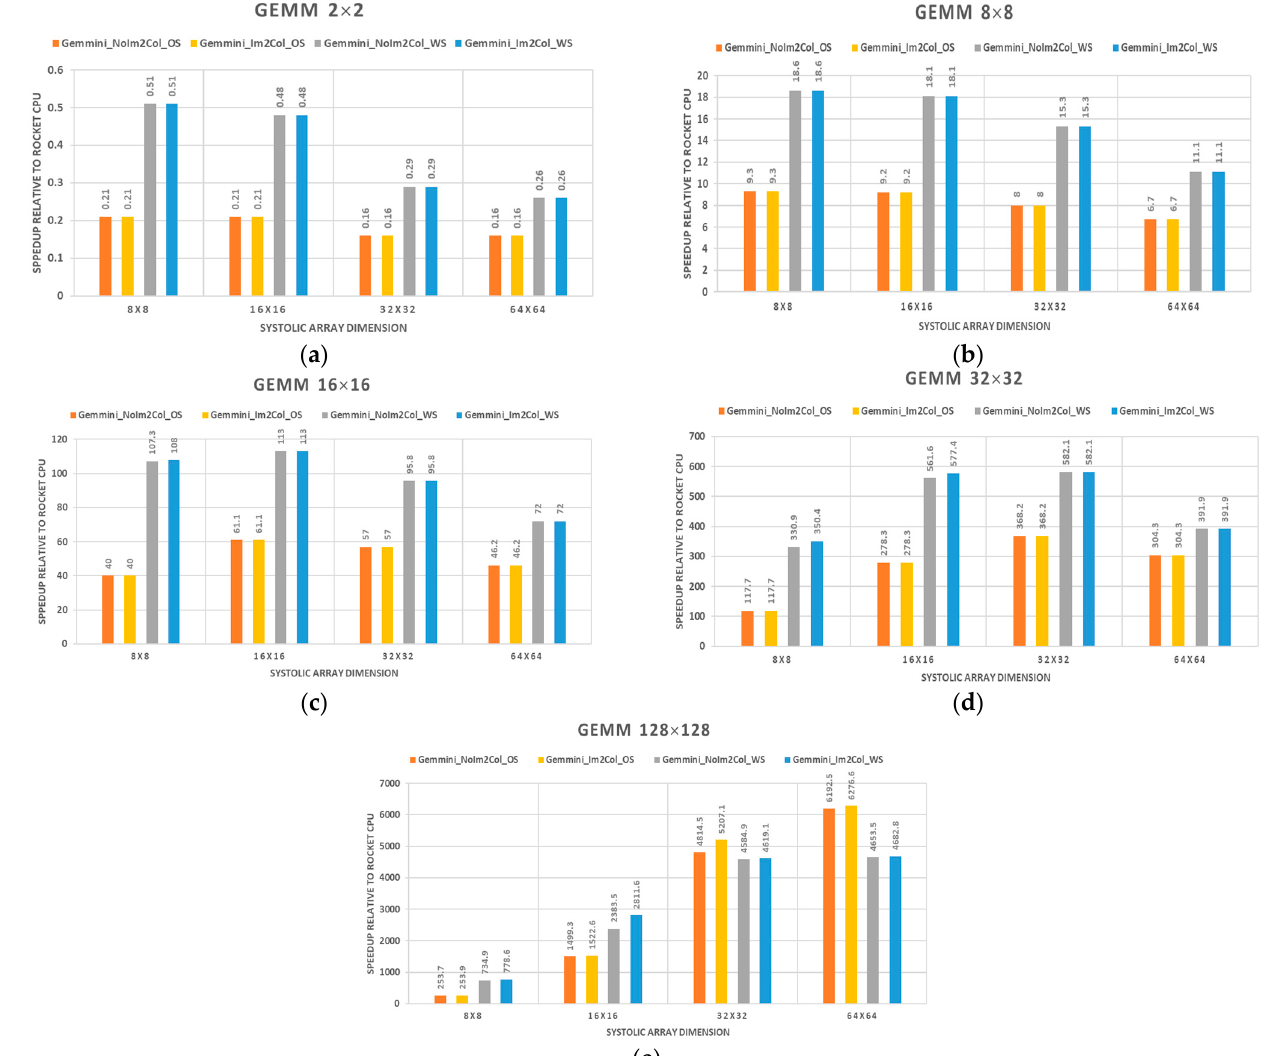
Figure 15. Gemmini accelerator speedups relative to the baseline Rocket CPU core (above 1 indicates a speedup while less than 1 indicates a slowdown): ( a ) 2 × 2 GEMM; ( b ) 8 × 8 GEMM; ( c ) 16 × 16 GEMM; ( d ) 32 × 32 GEMM; ( e ) 128 × 128 GEMM.